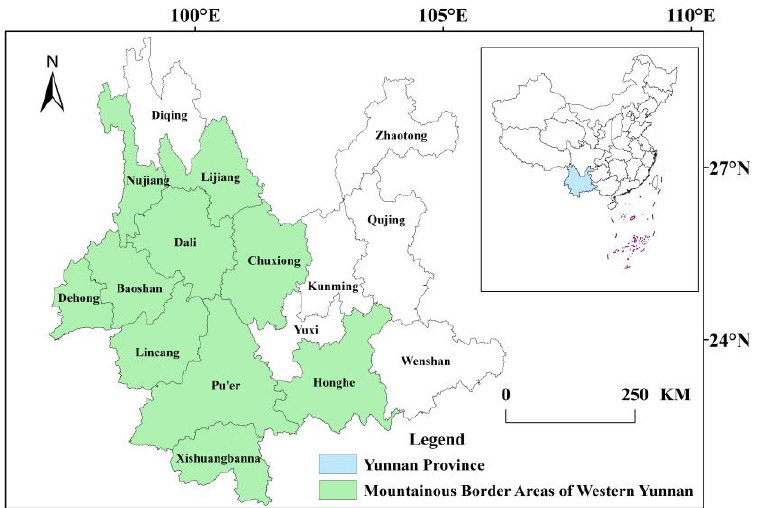
Figure 2. Research area. Note: This map is based on the standard map of GS (2019)1822, downloaded from the standard map service website of the Ministry of Natural Resources. The base map is not modified, and the same applies below.